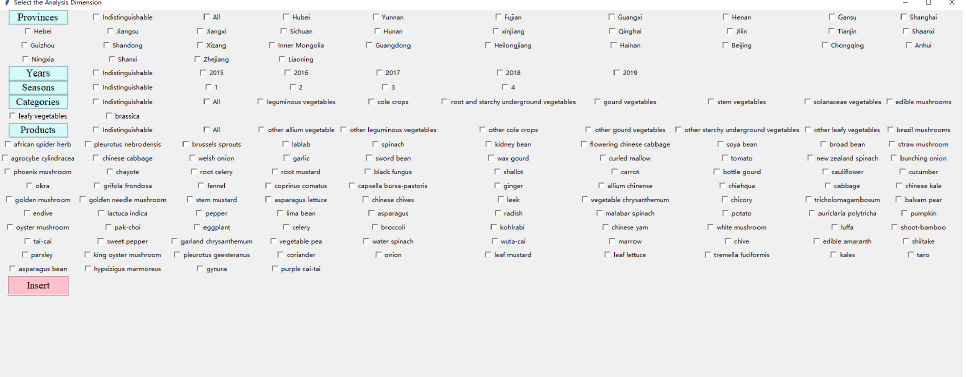
Figure 7. The multi-dimensional data analysis